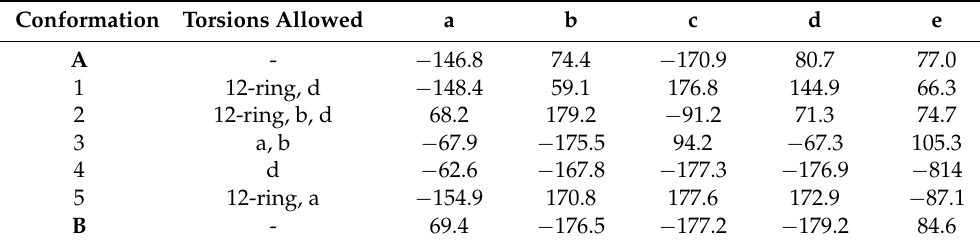
Table 1. Torsion angles ( ˝ ) in the tail for different conformations obtained with MCMM, starting with conformation A .